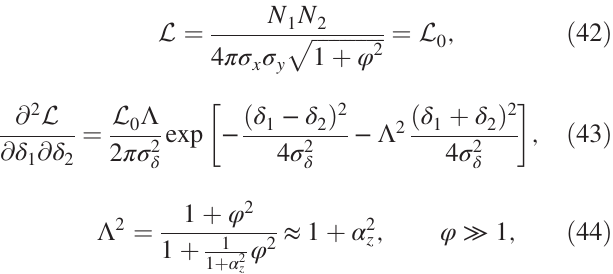
ffiffiffiffiffiffiffiffiffiffiffiffiffiffi p 1 þ φ 2